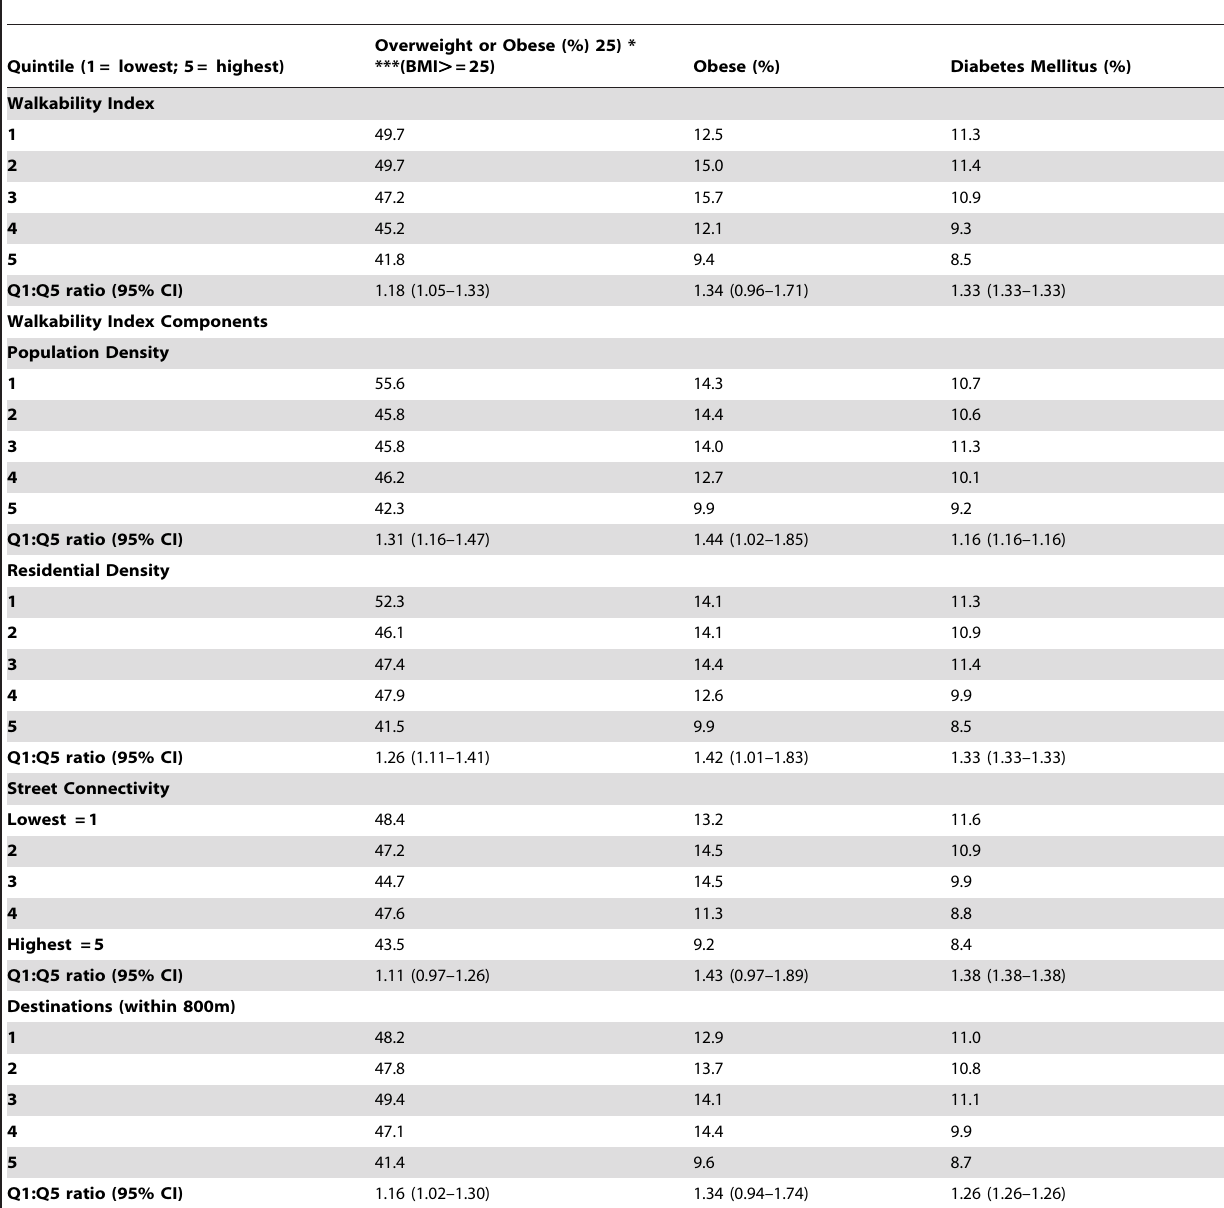
Table 3. Prevalence of Overweight*, Obesity,* and Diabetes** by Quintiles of Walkability and its Components*** for adults aged 30–64 years.